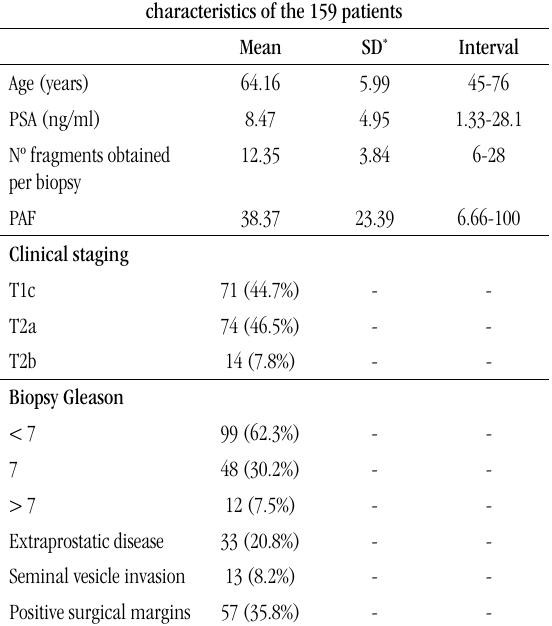
tABLE 1 – Clinical and pathological